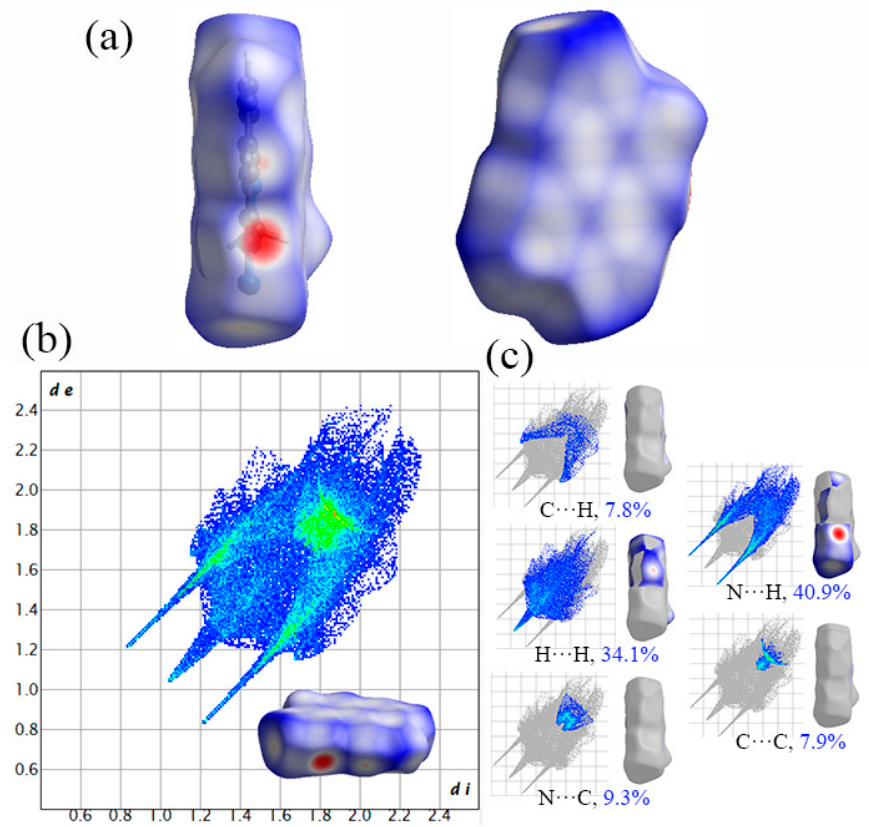
Figure 5. Hirshfeld surfaces and the corresponding 2D fingerprint plot of Crystal a : ( a ) Hirshfeld surfaces; ( b ) 2D fingerprint plots; ( c ) populations of close interatomic contacts.